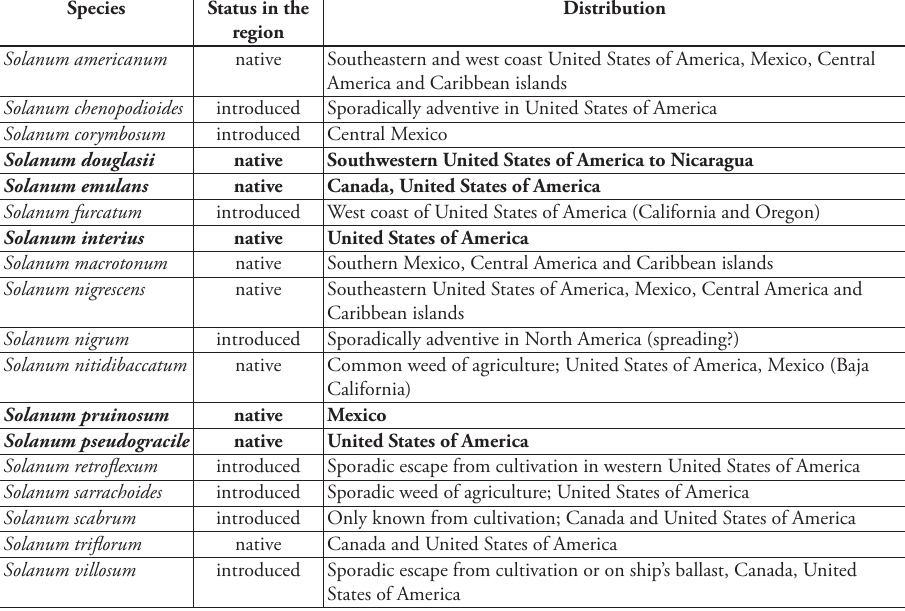
Table 3. Status and general distribution of the Morelloid Clade in the Caribbean, North and Central America; regionally endemic taxa are in boldface